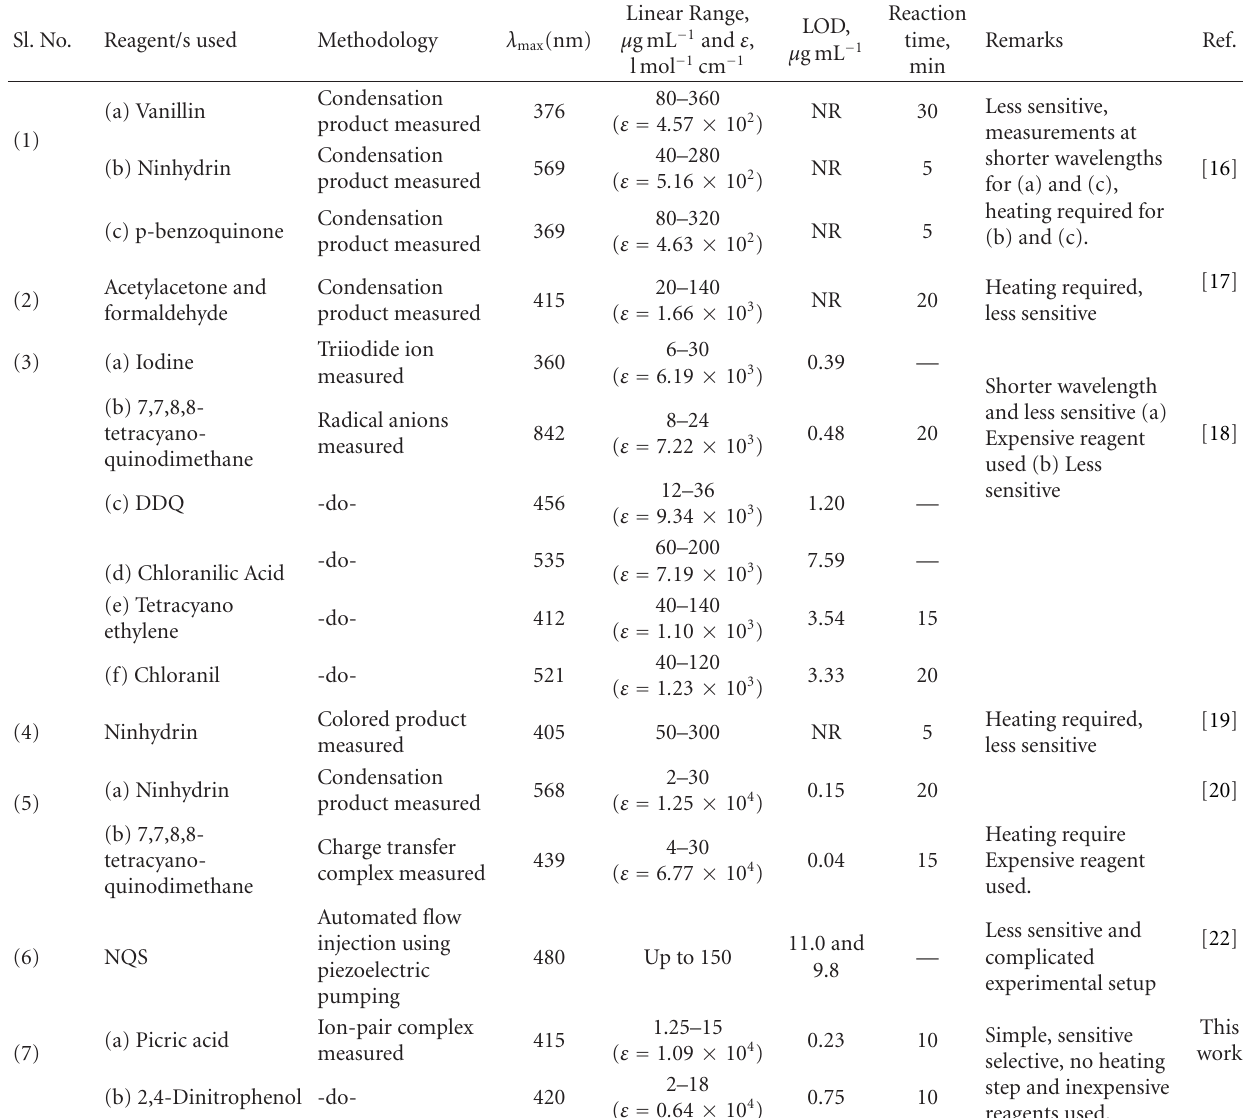
Table 2: Comparison of the proposed and the existing visible spectrophotometric methods. Sl.